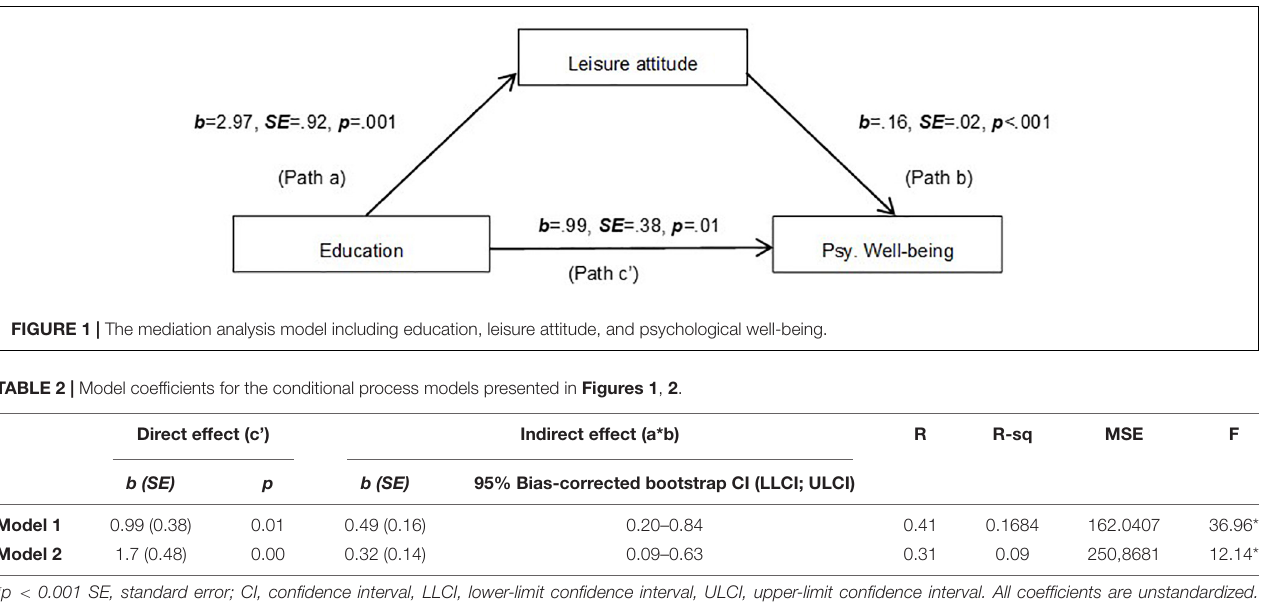
Figure 1 . Education explained 2.76% of the variance of